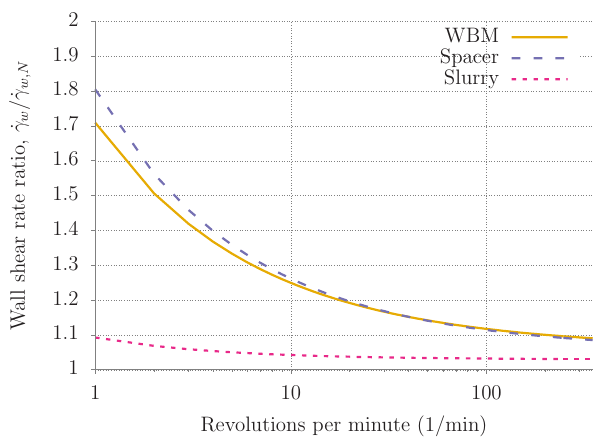
Figure 11: Ratio of actual (Herschel-Bulkley) wall shear rate to the Newtonian shear rate in a Fann Model 35 R1-B1 geometry for the three example fluids in Table